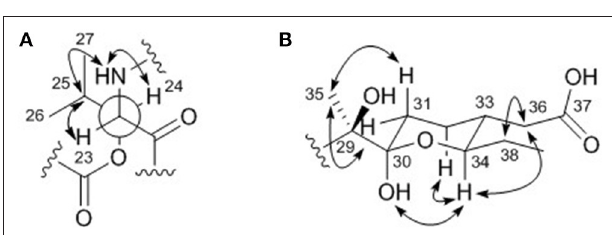
FIGURE 4 | Key ROESY correlations (double headed arrows) for determining the relative configurations of (A) the β -hydroxy leucine and (B) the acyl chain in dentigerumycin E ( 1